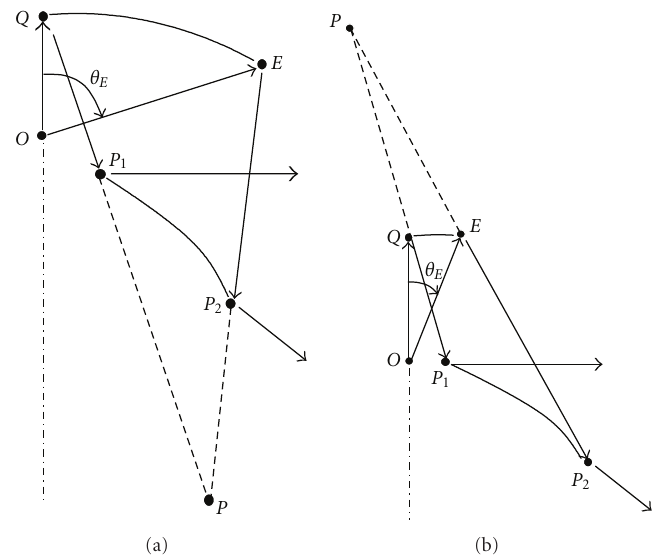
Figure 1: Some di ff erent configurations for the generating curves of OADC sub- and main-reflectors.